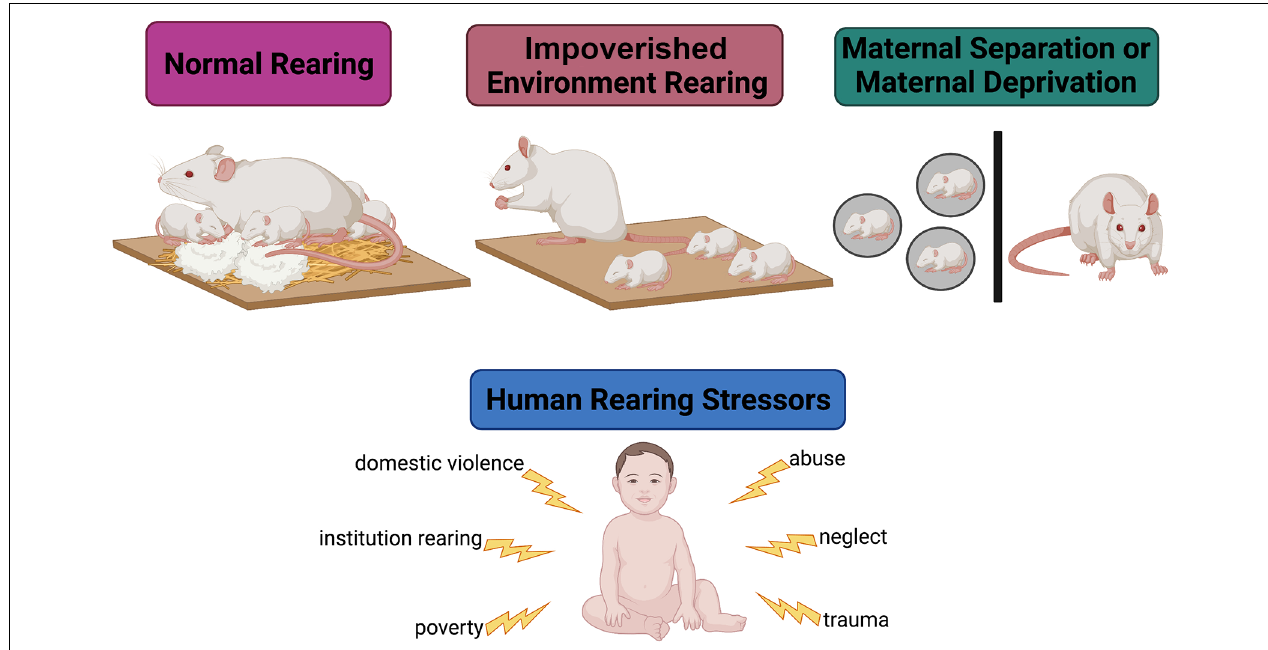
FIGURE 2 | Modeling early-life adversity in the laboratory. Under normal rearing conditions, a rodent dam is provided with ample bedding and nesting material. In this environment, she engages in many nurturing behaviors (arched-back nursing, nest hovering, and pup licking) and a few aversive behaviors (stepping on, dragging, dropping, and actively avoiding) towards the pups. Under impoverished conditions, the dam is not provided with enough bedding or nesting material to create a nest. This environment causes stress in the dam, leading her to engage in less nurturing behaviors and more aversive behaviors towards the pups. In maternal separation models, the pups are removed from the dam to simulate neglect. These models are utilized to emulate human-experienced early-life